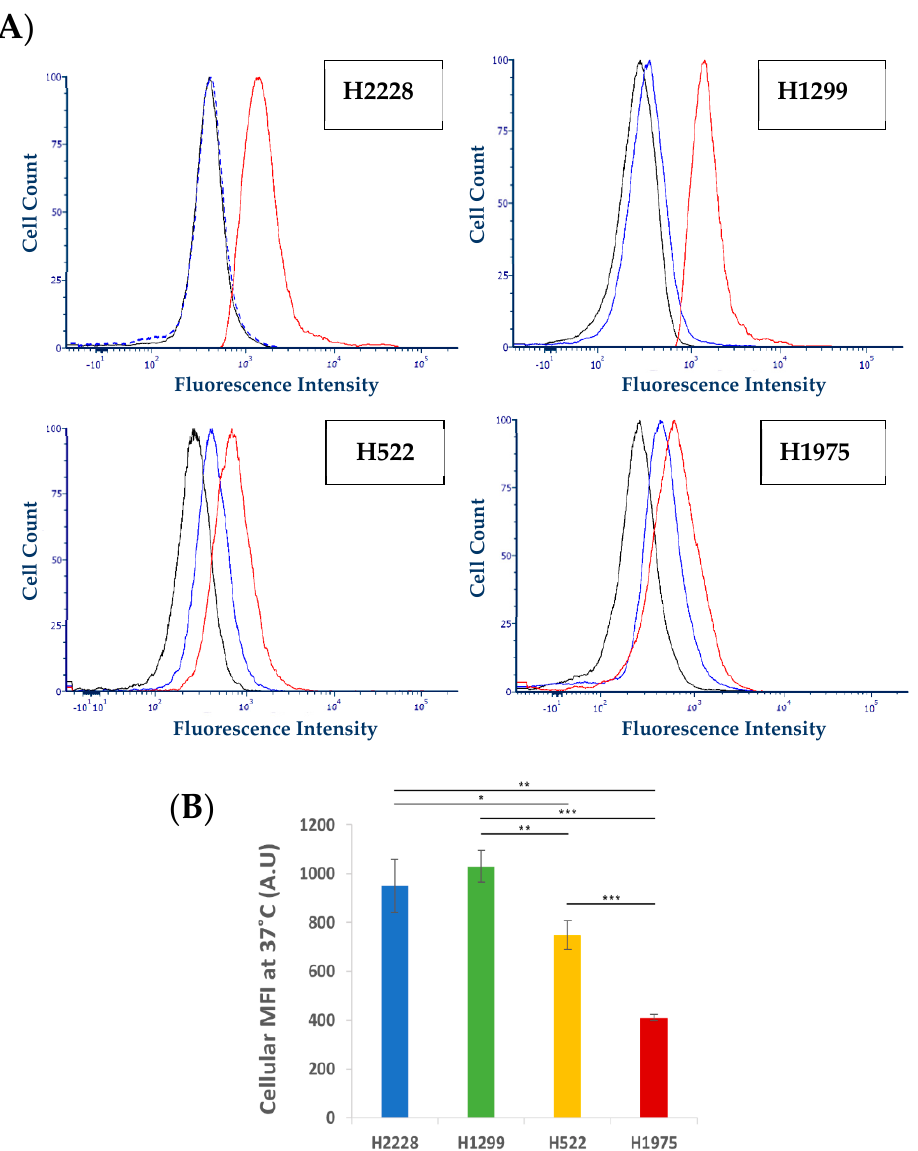
Figure 5. Internalization of APT-QDs in various NSCLC cell lines. ( A ) Cellular fluorescence profiles: APT-QDs exposed to the NSCLC cell lines H2228, H1299, H522 and H522 at 37 ◦ C and 4 ◦ C for 1 h, followed by a 15 min trypsin treatment to remove membrane bound APT-QDs. Black line: control, unstained cells. Blue line: cells incubated at 4 ◦ C. Red line: cells incubated at 37 ◦ C. ( B ) Mean intracellular fluorescence intensity values ± SE after APT-QD exposure at 37 ◦ C. Autofluorescence was subtracted. * p < 0.05, ** p < 0.01, *** p < 0.001, unpaired, two-tailed t -test.